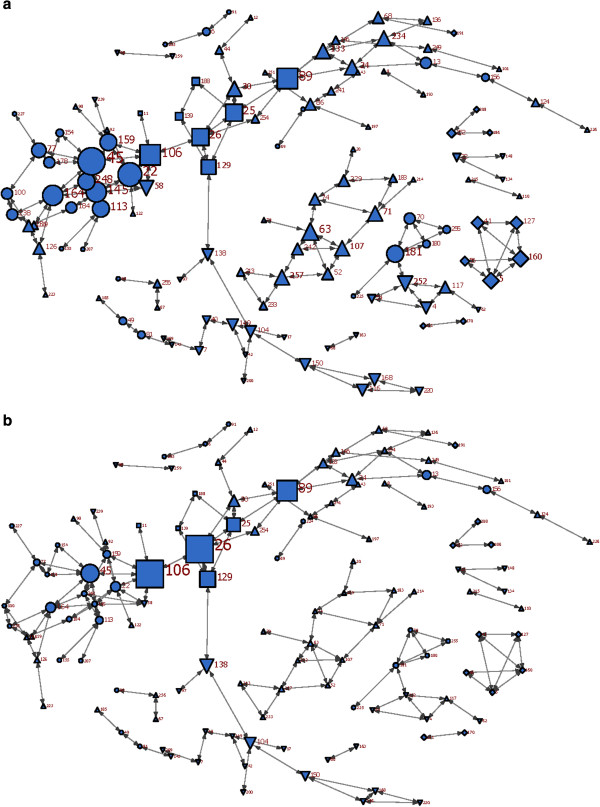
Symmetric friendship (Q4) network (Symmetrized by maximation) 3a: nodes are sized by their degrees, 3b: nodes are sized by their betweenness.Up-triangle: #1 Diamond: #2Square: office of the Medical Officer of Health Circle: #4Down-triangle: #5.